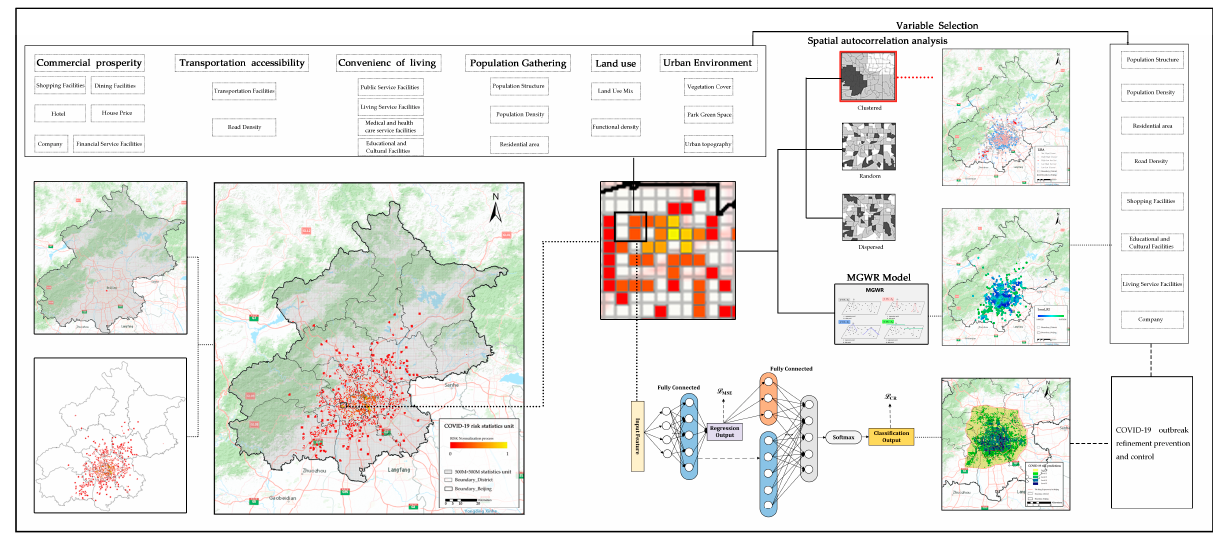
Figure 1. Graphical Abstract